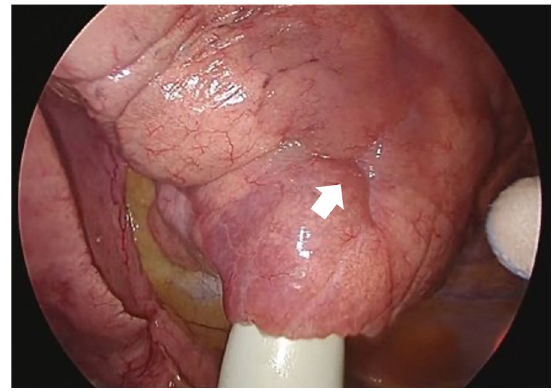
visceral pleura (white arrow)